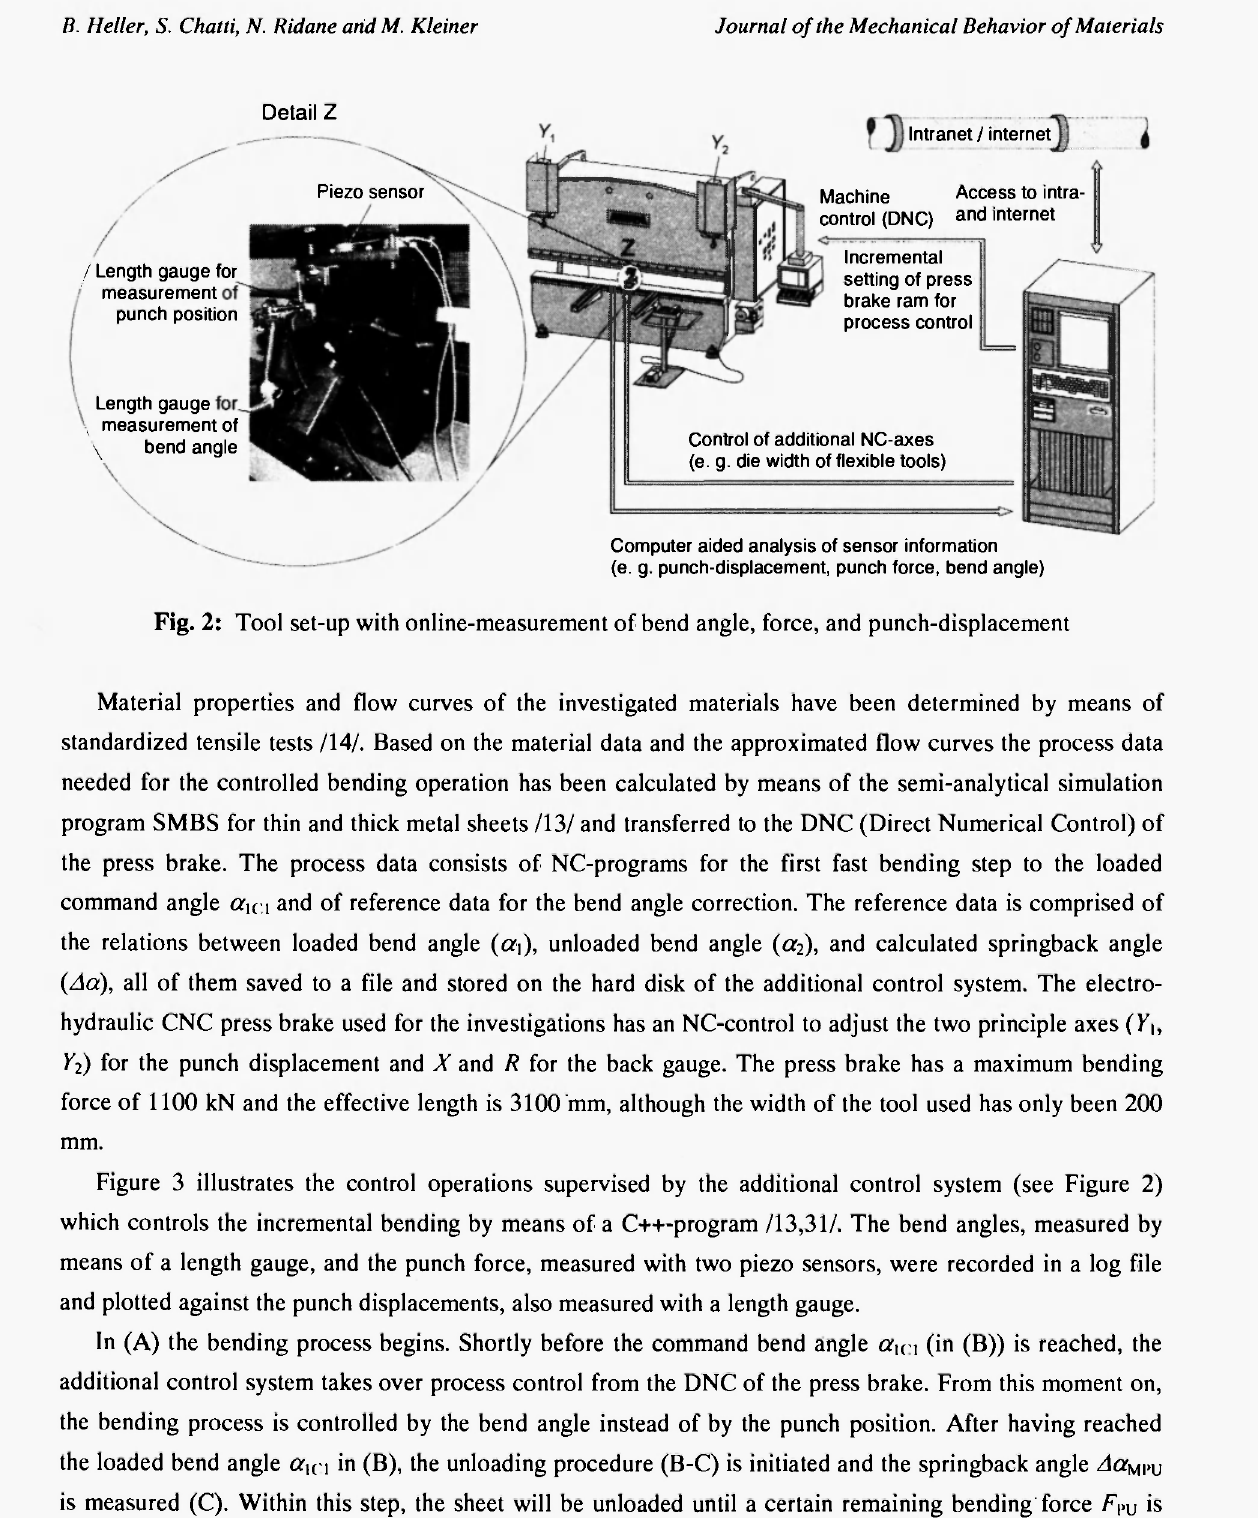
program SMBS for thin and thick metal sheets /13/ and transferred to the DNC (Direct Numerical Control) of the press brake. The process data consists of NC-programs for the first fast bending step to the loaded command angle a